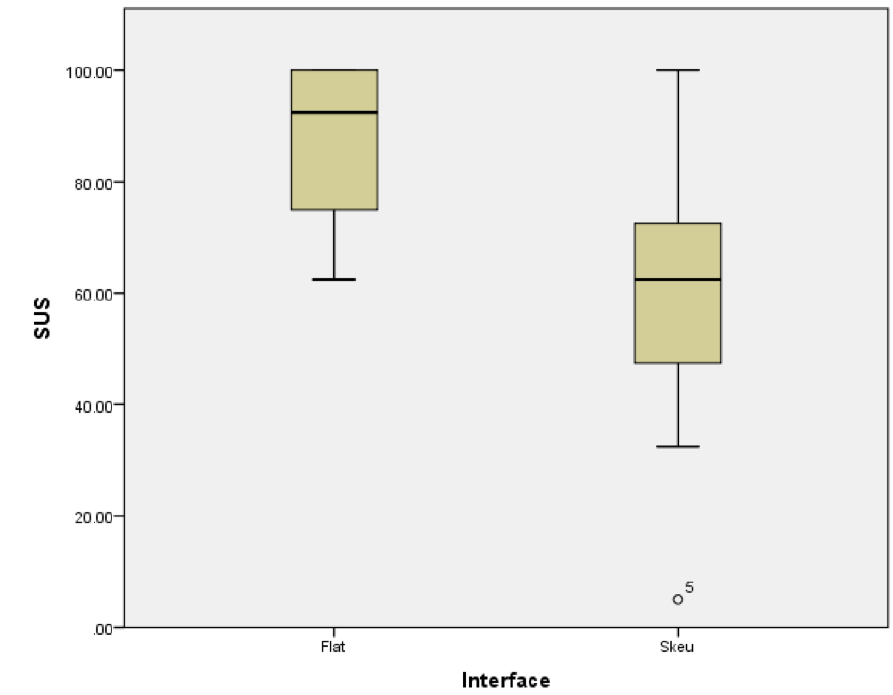
A summary of the results of the SUS questionnaires for each interface for the second